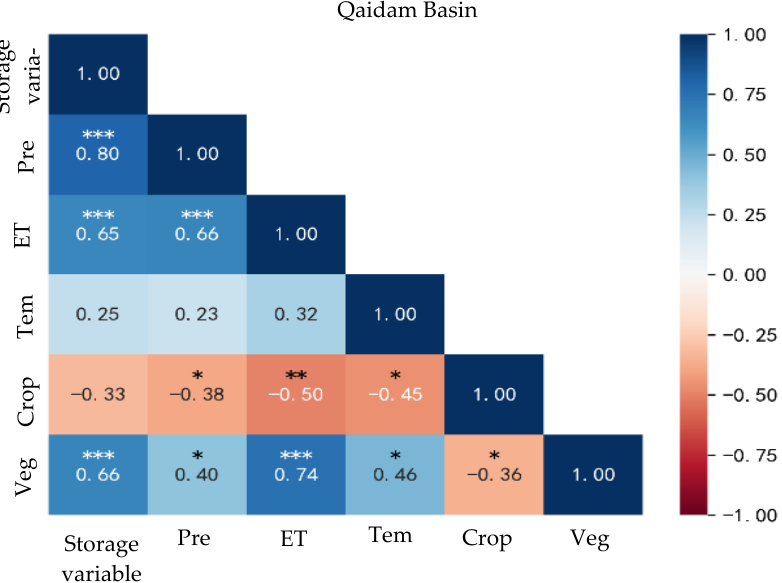
Figure 14. Correlation among lake storage, climate and land cover elements in the Qaidam Basin. Pre: precipitation; Eva: evapotranspiration; Tem: air temperature; CL: cropland; Veg: vegetation. * denotes p -value < 0.05, ** denotes p -value < 0.01, *** denotes p -value < 0.001.